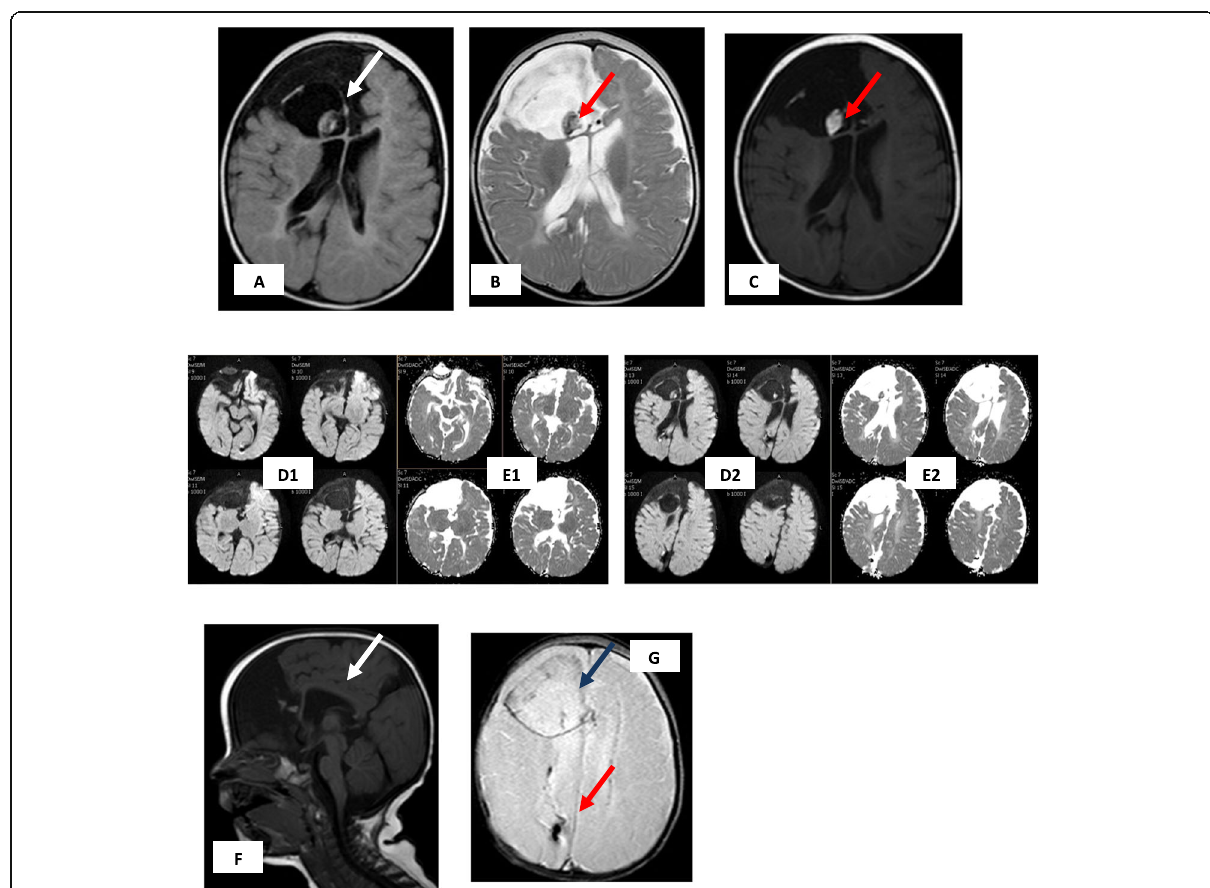
Fig. 7 24-days-old premature girl (33 weeks of gestation), with PVL . MRI reveals right frontal cystic lesion (white arrow in A ) compressing the frontal horn of the right lateral ventricle, with intra-cystic small hemorrhagic component (red arrow) displaying high T1 and low T2 signal with minimal blooming at T2*(blue arrow in G ). Another hemorrhagic foci at the right posterior parietal region (red arrow in G ). Abnormal peri- ventricular white matter signal intensity displaying mild high signal at FLAIR and T2WI with no restricted diffusion. Markedly thinned corpus callosum (white arrow in F